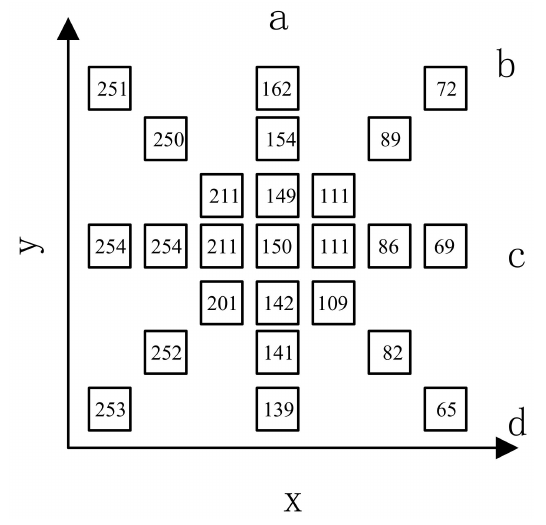
Figure 5. Algorithm flow.